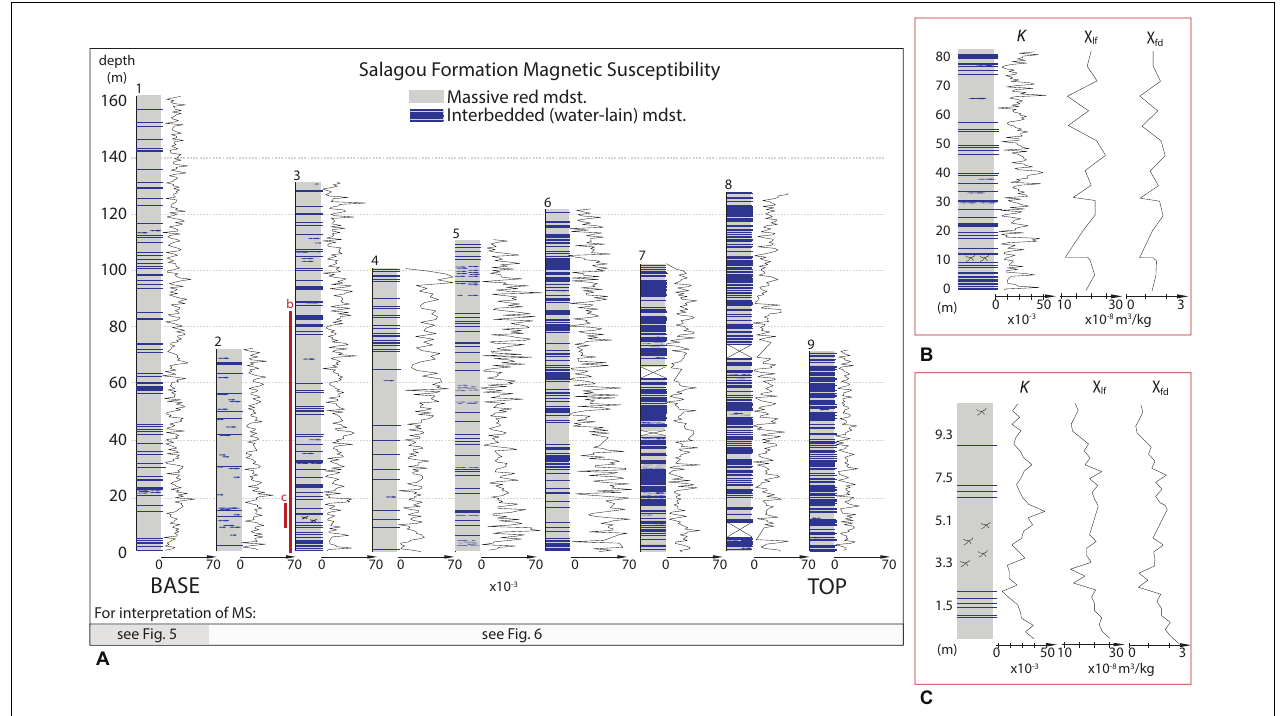
FIGURE 3 | Rock magnetic data from the Salagou Formation. (A) Stratigraphy with handheld (outcrop) MS data (in units of 10 − 3 ). Section are numbered for reference and correspondence to Table 2 . The dotted lines indicate depth intervals (see meter marks at left). The red bars on Section #3 represent the locations of detailed profiles sampled at two different intervals for detailed rock magnetic data ( B,C ; see insets). Bar at bottom of page indicates which stratigraphic section correspond with each interpreted MS series in Figure 5 (#1 only) and Figure 6 (#2–9). (B,C) Focused view showing the stratigraphy and outcrop MS again, but also displaying rock magnetic data obtained for these intervals. Specifically, mass normalized low-field MS ( χ lf) at 505 Hz in 10 − 8 m 3 /kg and delta χ ( χ fd). (B) An 80-m section sampled at 5-m intervals. Note the pedogenic interval ∼ 11 m. The correlation between MS measured in the field to χ lf is negligible ( r 2 = 0.0059), but the relationship between the two datasets is highly significant ( P -value < 0.05). (C) A 10-m section sampled at 30-cm intervals. Note the pedogenic interval ∼ 3–5 m. The correlation between MS measured in the field to χ lf is weak ( r 2 = 0.1758), but the relationship between the two datasets is highly significant ( P -value < 0.05).